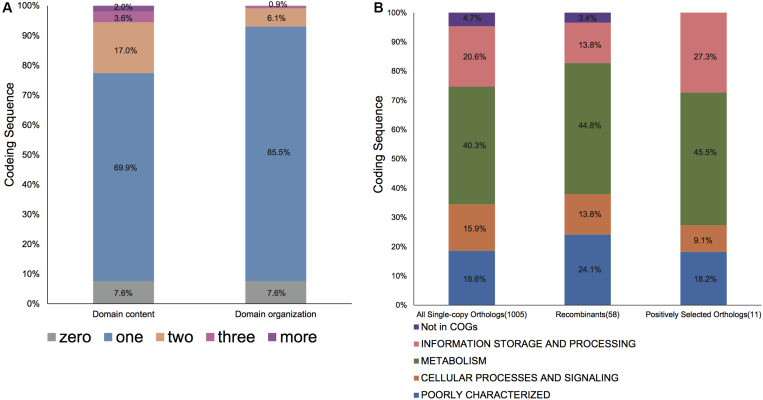
The protein composition and function distribution of single copy genes in Bcc. (A) The domain content repertoires and domain organization repertoires distribution of all 1005 orthologous families. The domain content repertoire of an ortholog is defined as the set of domains that occur in the proteins of the orthologous family; domain organization represents the sequential protein domain order; for an ortholog, domain organization repertoire is referred to as a group of domain organizations for each encoded protein within the orthologous family. Note that one ortholog including four different domain organizations was not shown in the figure. (B) The COG functional distribution of all single copy genes, evidently recombinant genes, and genes under positive selection. The number of each typical ortholog is given in parentheses. The functional classes are colored as listed in the bottom. Each category is graphed as a percentage of the total number of othologs in the corresponding gene set.